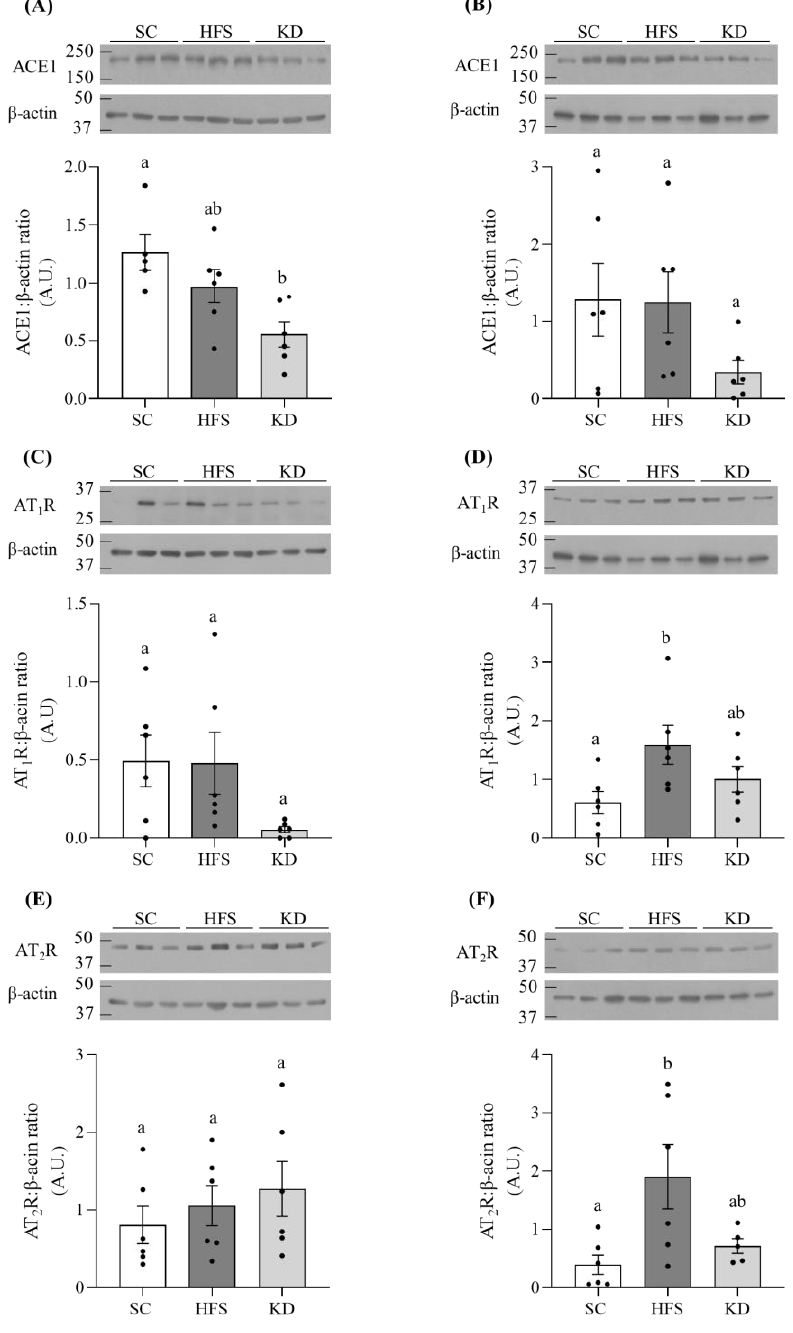
Figure 2. The KD attenuated angiotensin converting enzyme 1 (ACE1) and angiotensin II, type I receptor (AT 1 R) contents in pulmonary tissue ( A , C , respectively), however only the former was found to be statistically significant. Angiotensin II, type 2 receptor (AT 2 R) was unaltered in the lungs, regardless of diet ( E ). On the other hand, dietary intervention did not influence heart ACE1 content ( B ), however AT 1 R and AT 2 R were significantly elevated in the cardiac tissues of HFS-fed rats ( D , F , respectively). Significant differences are denoted by different letters p < 0.05. Bars represent mean ± SEM. One-way ANOVA, n = 5 – 6.